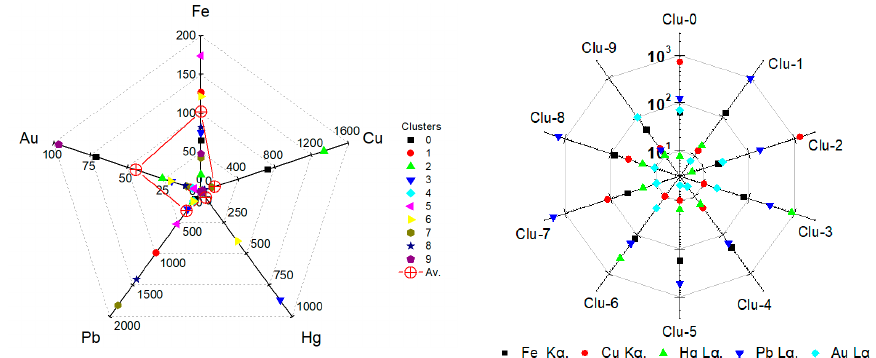
Figure 8. Intensities of Fe K α , Cu K α , Au L α , Hg L α and Pb L α transitions for each cluster, extracted with the method of ROI from the representative spectra. Left : Intensities of specific transitions (that pertain to a specific element) for the various clusters. As an example, the maximum intensity of the Fe K α is about 175 counts, and it is observed in Cluster 5, while the maximum intensity of the Cu K α (~1300 counts) is in Cluster 2. The average transition intensities per pixel are marked by red crosses. Right : Transition intensities per specific cluster. For instance, in Cluster 2 the maximum intensity corresponds to the Cu K α , followed by the Pb La.